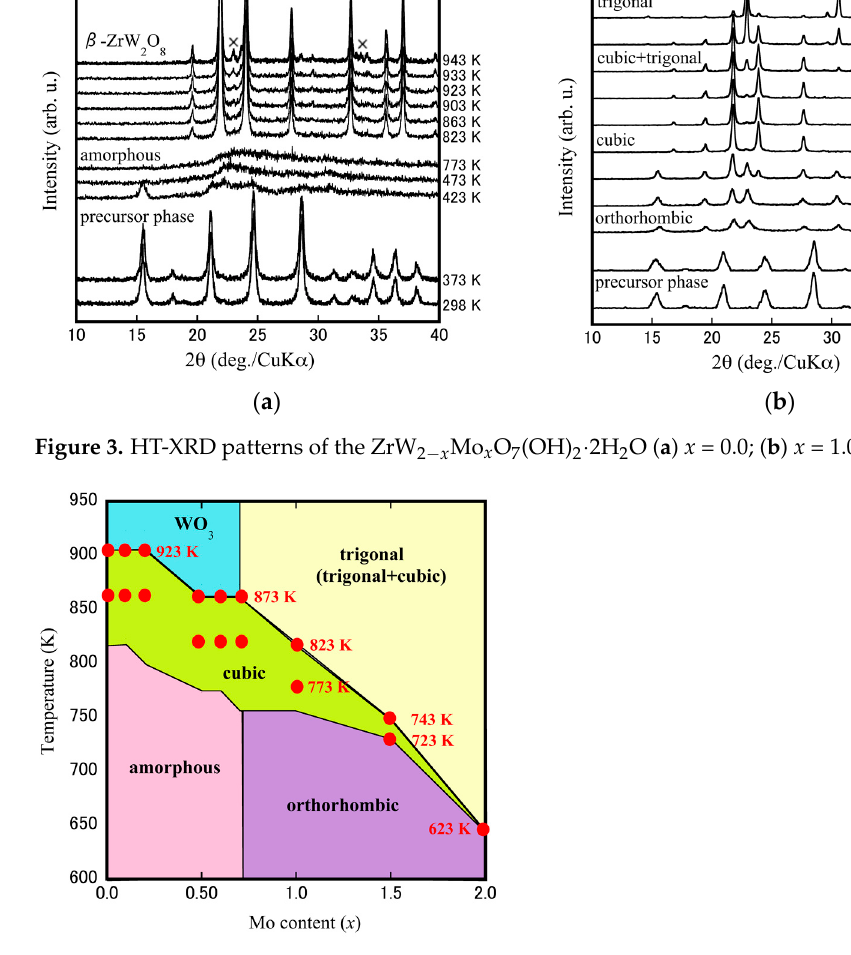
Figure 4. Data on the temperatures of the phase transformation for ZrW 2 − x Mo x O 7 (OH) 2 · 2H 2 O precursors obtained by HT-XRD during the heating procedure (the red point is the setting sintering temperature during SPS of each sample).